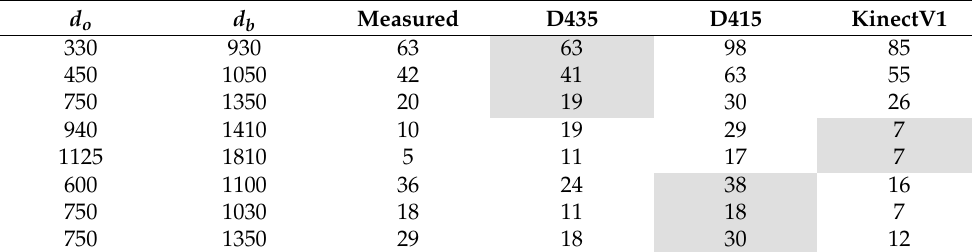
Table 3. Camera source identification. The measured shadow width is compared with the three expected shadow sizes calculated using the parameters of each of the three cameras. The true source camera is marked in